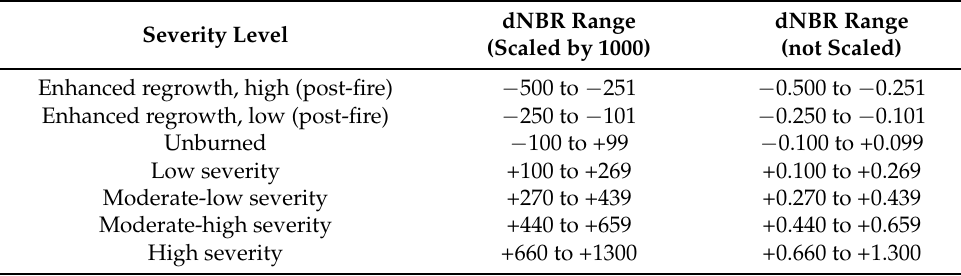
Table 2. U.S. Geological Survey (USGS) fire severity